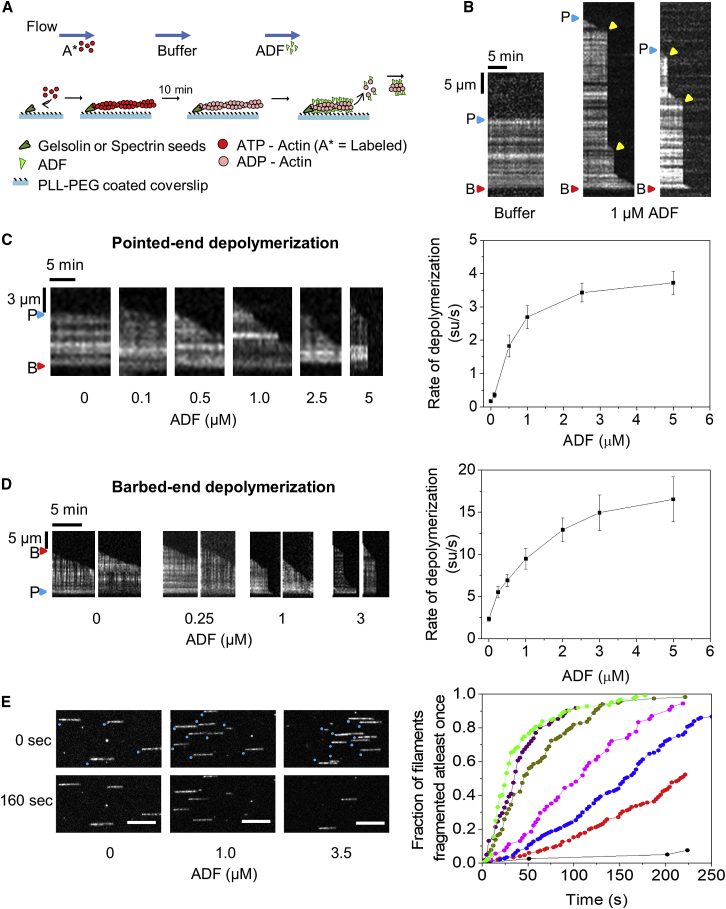
ADF Severs Filaments and Enhances Depolymerization at Filament Pointed and Barbed Ends(A) Schematics of the setup for single-filament depolymerization. Filaments exposing free pointed ends or barbed ends were grown from coverslip-anchored gelsolin-actin complexes or spectrin-actin seeds, respectively, and sequentially exposed to F-buffer and ADF in F-buffer.(B) Representative kymographs of ADP-F-actin filaments anchored at barbed ends (B, red triangle) and exposing free pointed ends (P, blue triangle) to either F buffer only (left panel) or 1 μM ADF in F buffer (two right panels). Severing events, yellow triangles.(C) ADF concentration dependence of pointed-end depolymerization. Left: representative kymographs. Right: rate of pointed-end depolymerization versus ADF (see Movies S1 and S2).(D) ADF enhances depolymerization at filament barbed ends. Left: representative kymographs. Right: barbed-end depolymerization rate versus ADF concentration (see Movie S3). Error bars represent SD; each data point represents the average of 50 measurements cumulated from three independent experiments. All depolymerization rates were found to be statistically significant (p < 0.05; two-sample t test) compared to the control (0 ADF).(E) Time-lapsed images of ADP-F-actin filaments with their pointed ends anchored (blue dots) and barbed ends capped being severed by ADF (flow direction: left to right) (see Movie S4; Figure S1) (left) and cumulative distribution function of the first severing event per filament as a function of time for different ADF concentrations—no ADF (black), 0.5 μM (red), 1 μM (blue), 2 μM (magenta), 3.5 μM (dark green), 5 μM (purple), and 10 μM (light green). Each curve consists of about 70–80 filaments of average length around 10 μm.